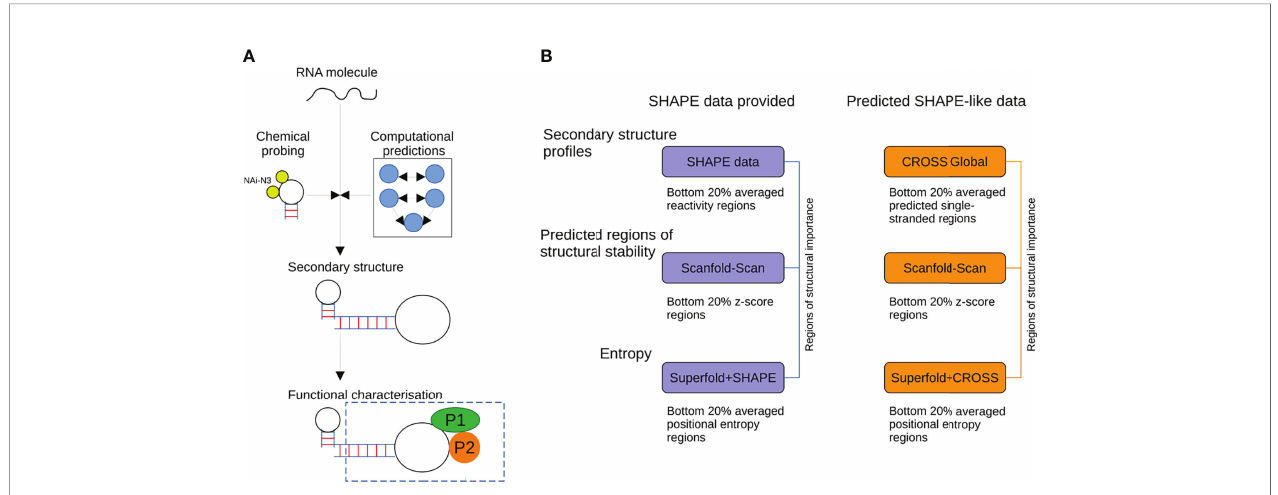
FIGURE 1 | (A) Graphical representation of how understanding the RNA secondary structure, by using experiments or predictions, is crucial to assess the functionality of a RNA molecule. (B) Work fl ow of RNAvigator explaining the differences in the two pipelines while using experimental data (SHAPE) or predicted secondary structure pro fi les ( CROSS ) as